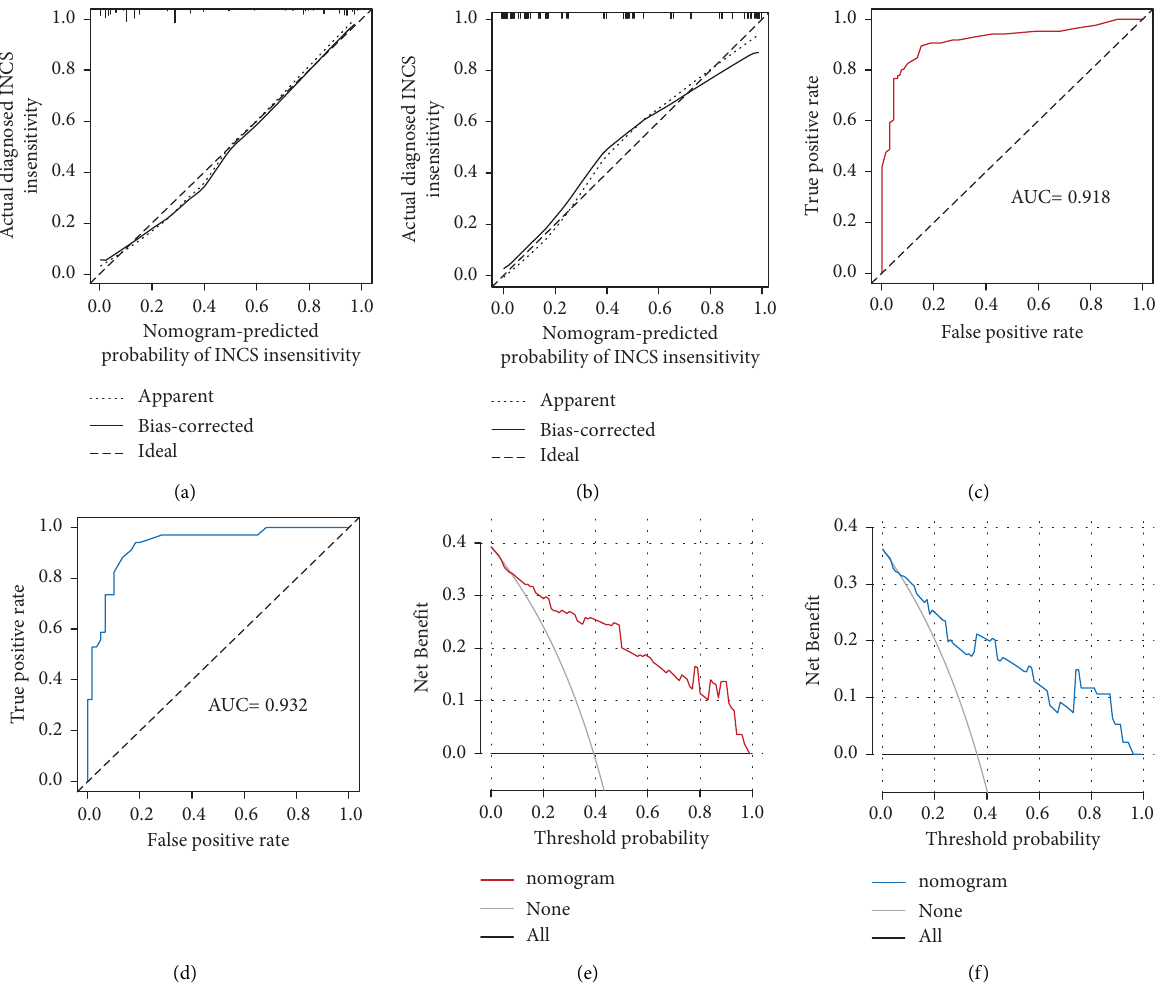
Figure 4: Te calibration curves of the nomogram for predicting the risk of INCS insensitivity in the training (a) and validation (b) cohorts. Receiver operating characteristic (ROC) curves were used to assess the model’s performance in the training (c) and validation (d) cohorts. Decision curves of the nomogram predicting the risk of INCS insensitivity in the training (e) and validation (f) cohorts are